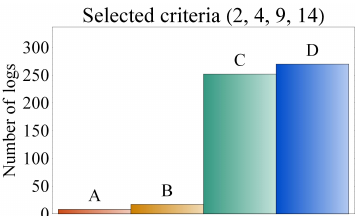
Figure 5. Results of visual grading with most influential characteristics (2, 4, 9, 14).